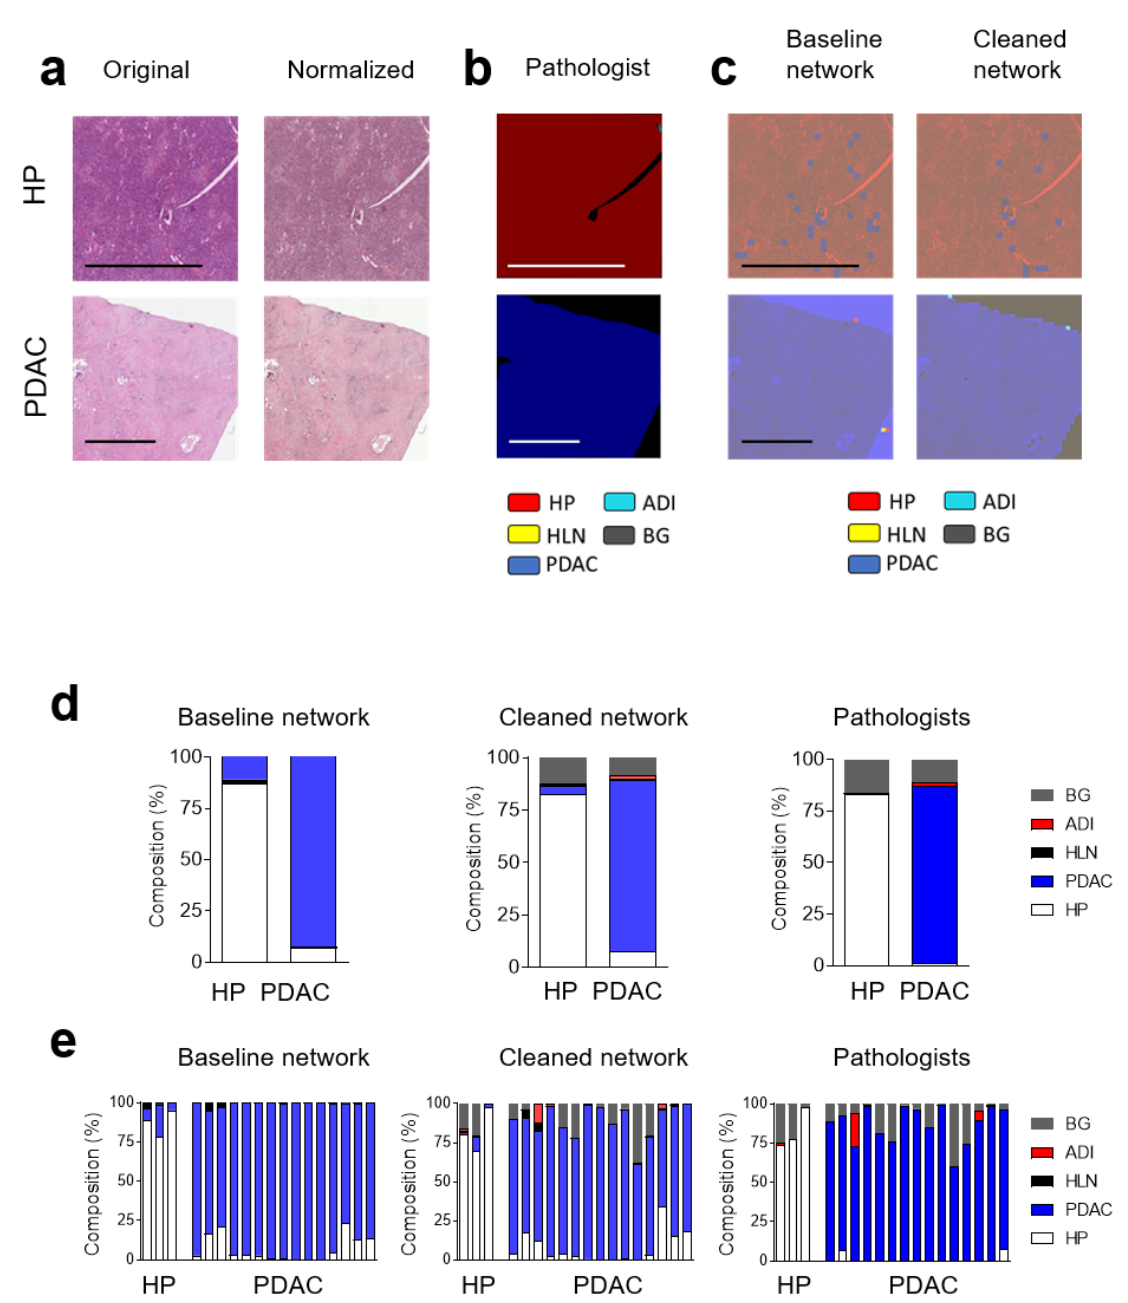
Figure 4. Convolutional Neural Network can classify healthy pancreas tissue and pancreatic ductal adenocarcinoma. ( a ) Sections from independent H&E-stained whole images from healthy pancreases (HP) and pancreatic ductal adenocarcinoma (PDAC) are shown (scale bar = 2 mm). ( b ) Expert label (ground truth), as determined by a pathologist and ( c ) classified with the baseline and cleaned network, are shown. HLN (yellow), HP (red), PDAC (blue), background (BG, grey) and adipose tissue (ADI, cyan) are indicated by the pathologist ( b ) or the CNNs ( c ). The pooled ( d ) and individual classification ( e ), as determined using a baseline and cleaned network, as well as by a pathologist, of whole-image slides from healthy pancreases (HP) ( n = 3) and pancreatic ductal adenocarcinoma (PDAC) ( n = 15) are shown.